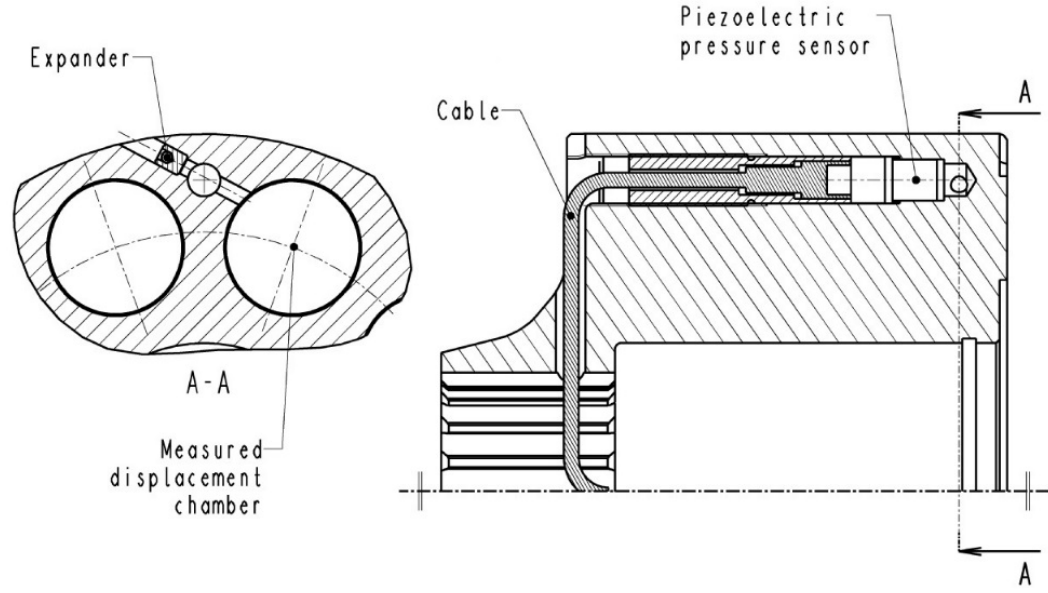
Figure 6. Implementation of the pressure transducer into the cylinder block.